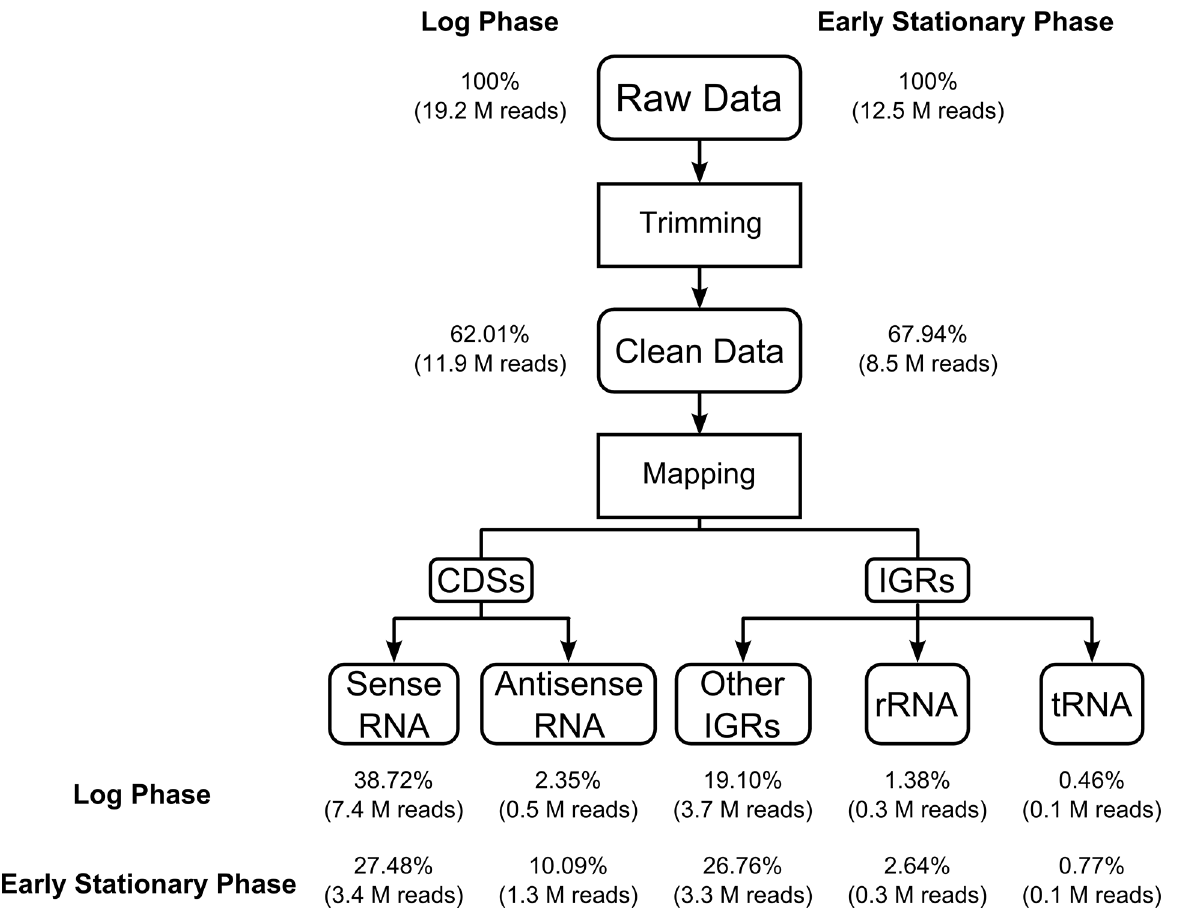
Figure 1. RNA sequencing profiles for both exponential and early stationary phase cultures of M. marinum . Number of reads obtained from data processing/mapping results and their percentage were indicated for both exponential and early stationary phase